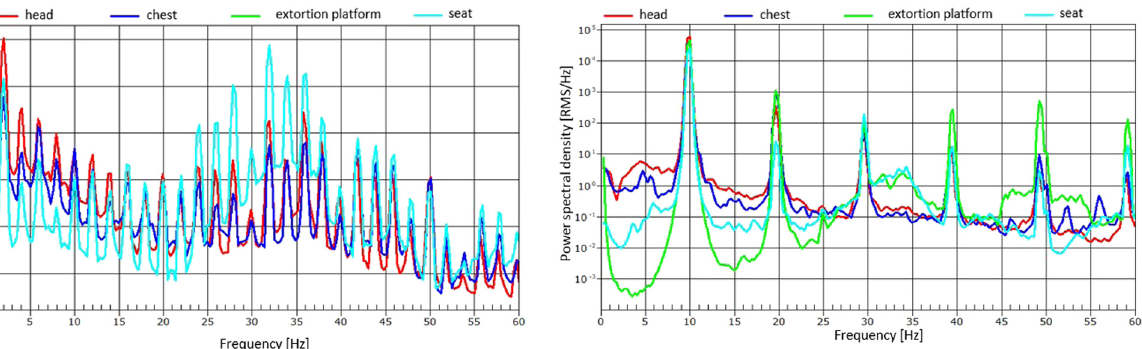
Figure 8: PSD for the 2 Hz excitation for the vertical direction.